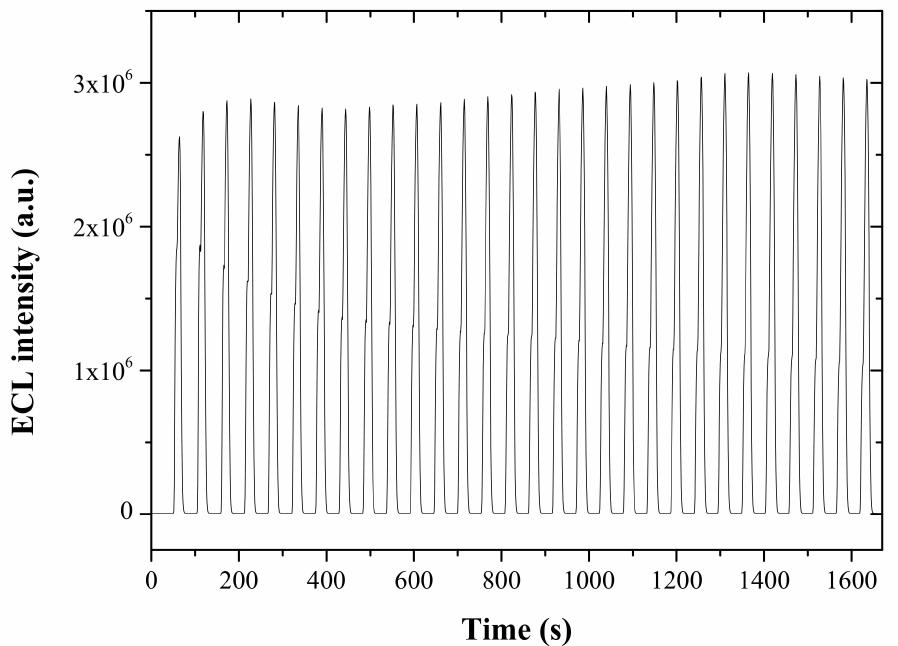
Figure 5. ECL-time responses with 30 consecutive measurements for 0.5 mM TPA in 0.05 PBS (pH 7.0) obtained by the one-step prepared ECL sensor based on the graphene-titania-Nafion composite film with a scan rate of 100 mV/s.